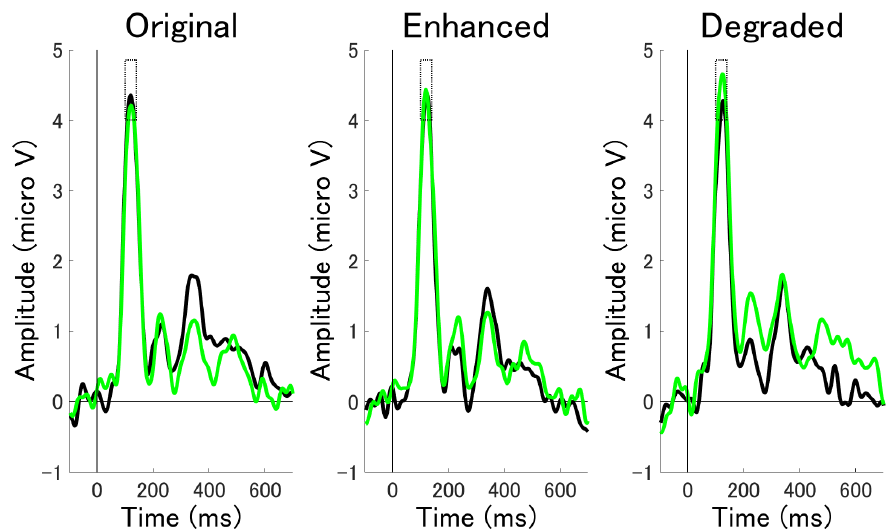
Figure 2. ERP waveforms recorded in each condition at left occipital sensor. The black and green lines represent ERP waveforms for self and other familiar faces, respectively. The rectangles drawn by the dotted line represent time windows used for mean amplitude measurement of P100.